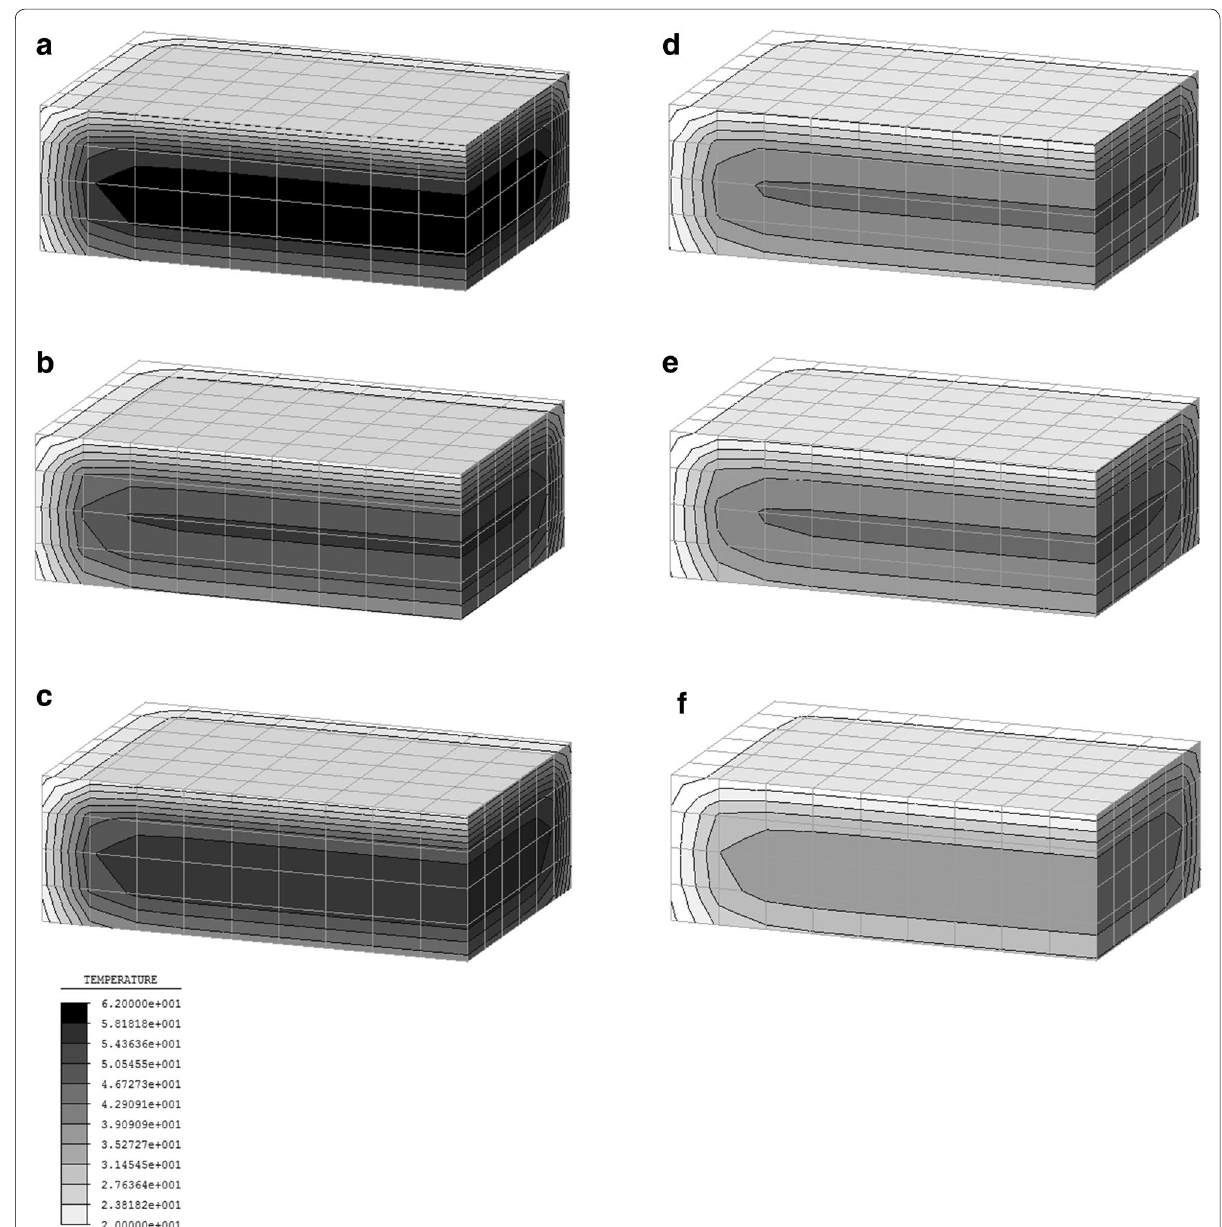
Fig. 8 Temperature distributions at the time of reaching the maximum temperature of each mixture; a OPC, b OPC CBF, f CBF +